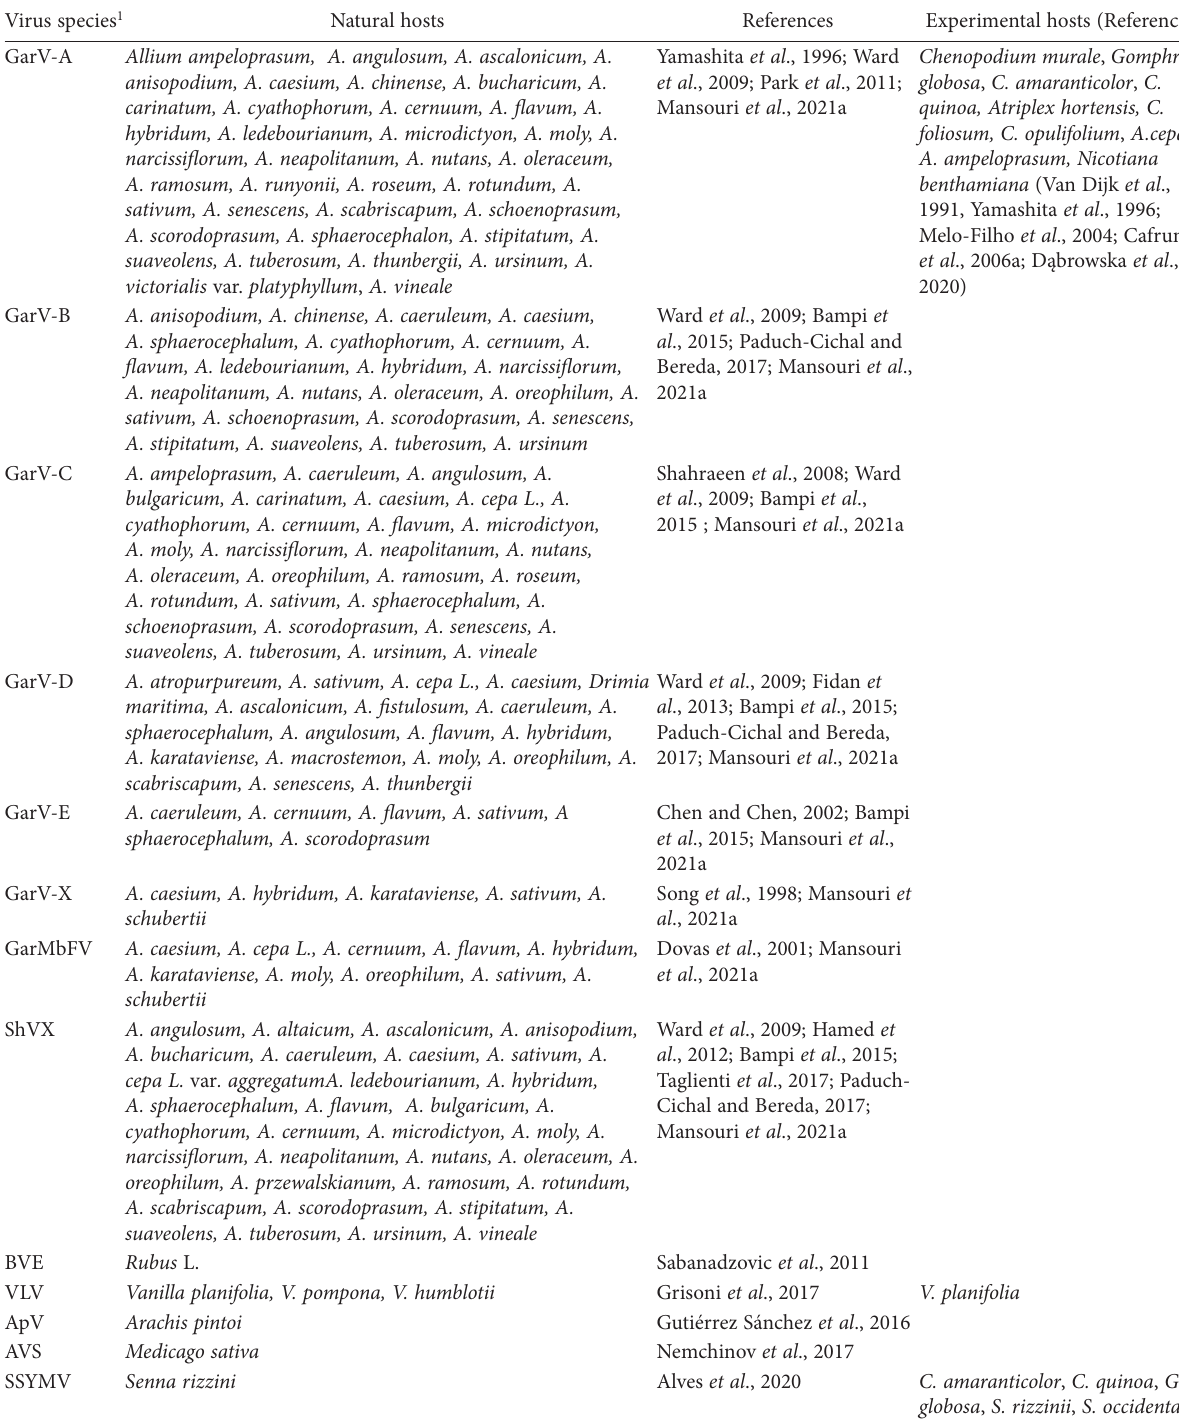
Table 3. Natural hosts and experimental host range when mechanically inoculated with one of